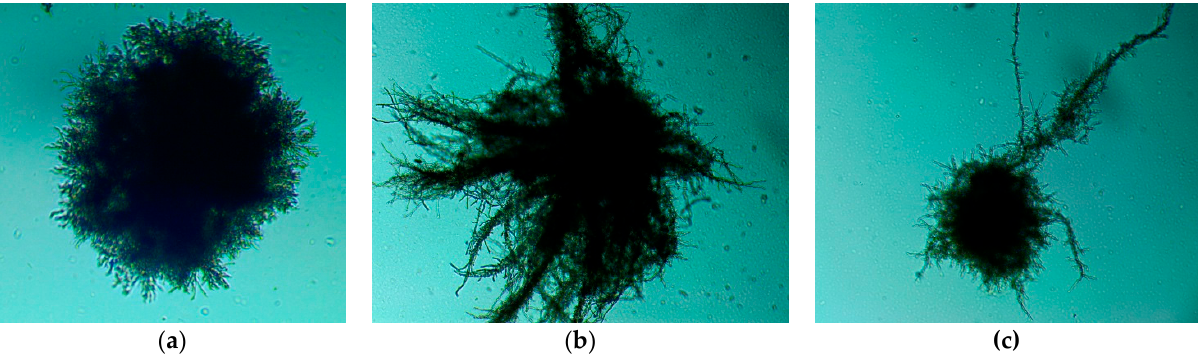
Figure 3. Pellets’ shapes in presence of n -dodecane ( a ) and absence of n -dodecane ( b , c ) on the third day of fermentation.